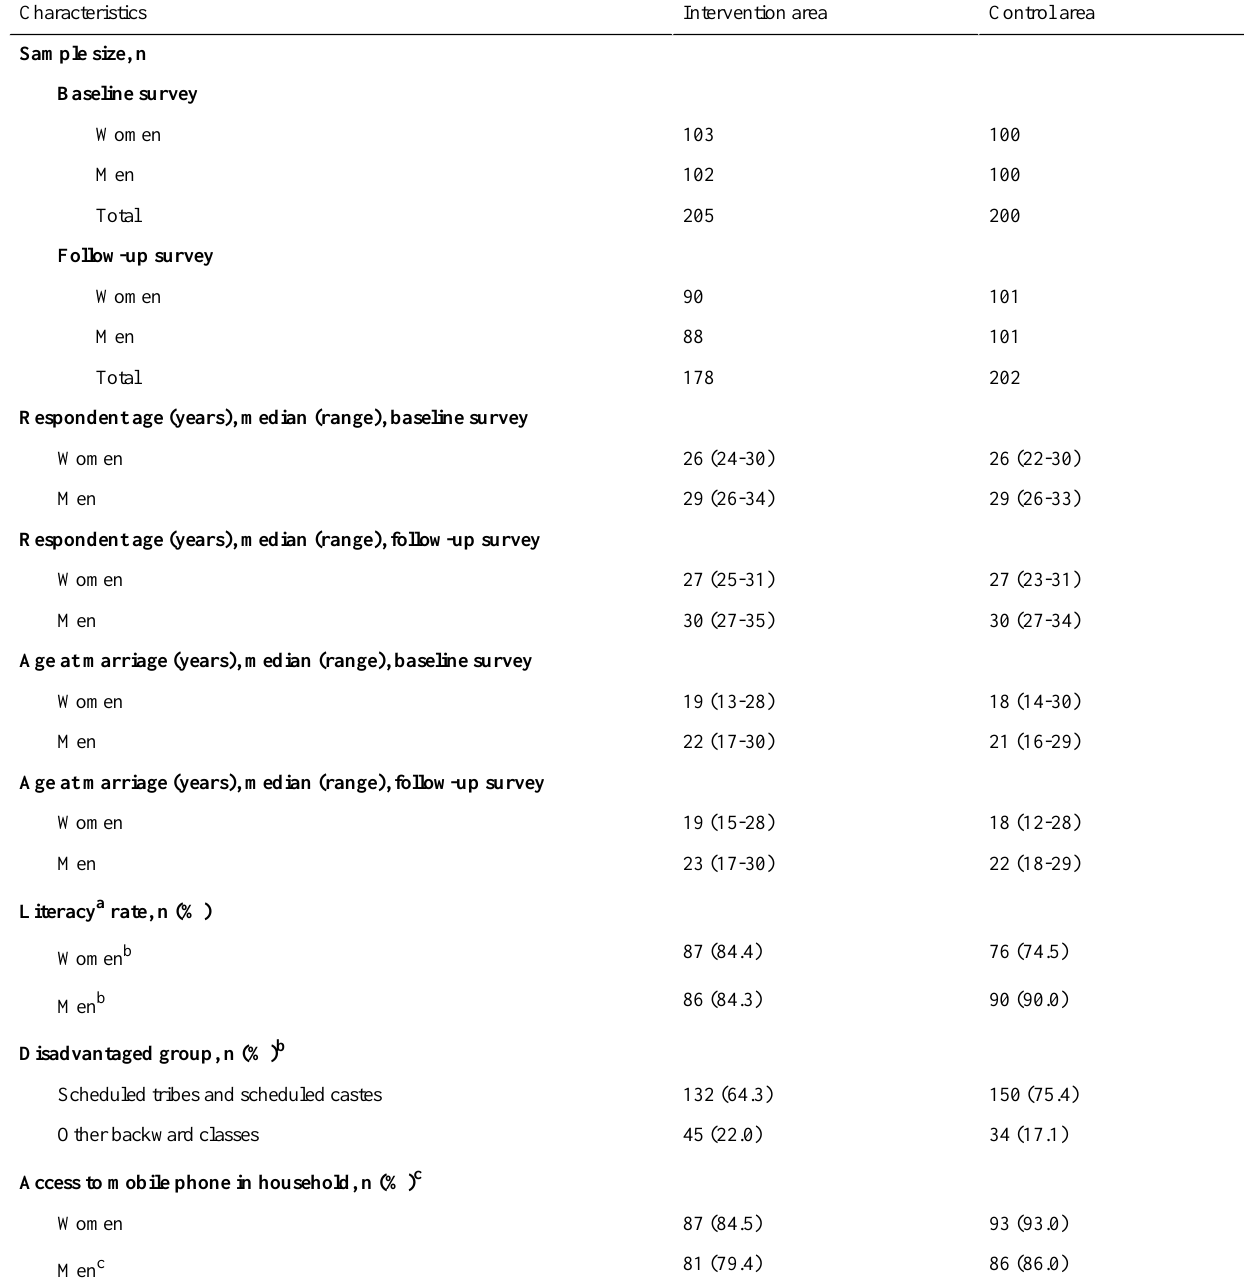
Table 1. Descriptive characteristics (source: baseline and follow-up surveys in two public health center areas in